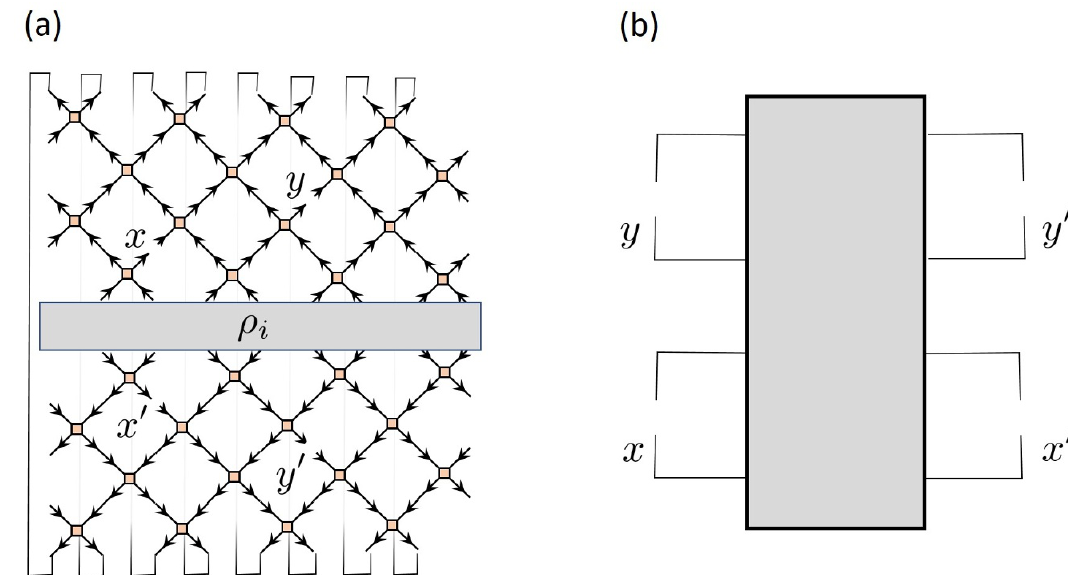
Figure 13 . (a) A Trotterized network comprised of a spacetime state contracted with its Hermitian conjugate with initial state (cid:26) i , and broken legs to allow the insertion of operators into x and y as well as x 0 and y 0 . (b) A more abstract superdensity operator, allowing for operator insertions at x and y as well as x 0 and y 0 .